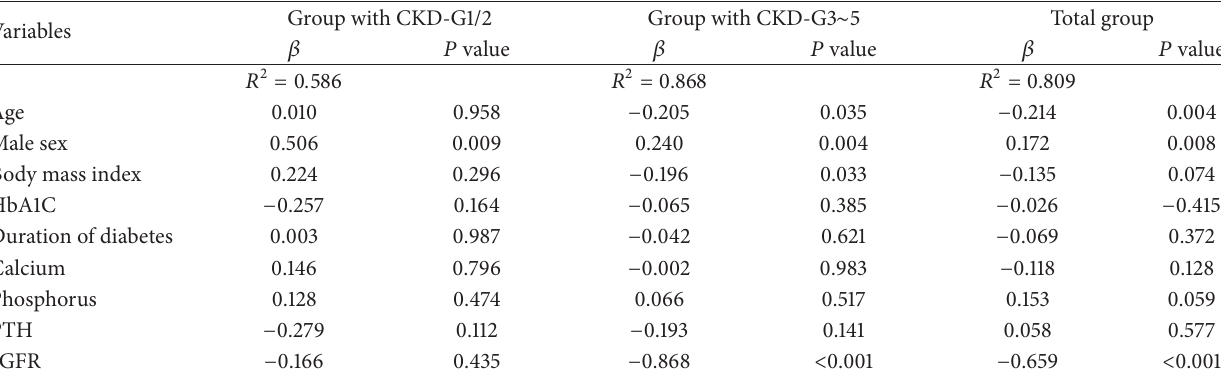
Table 3: Multiple regression analysis to identify factors associated with serum sclerostin